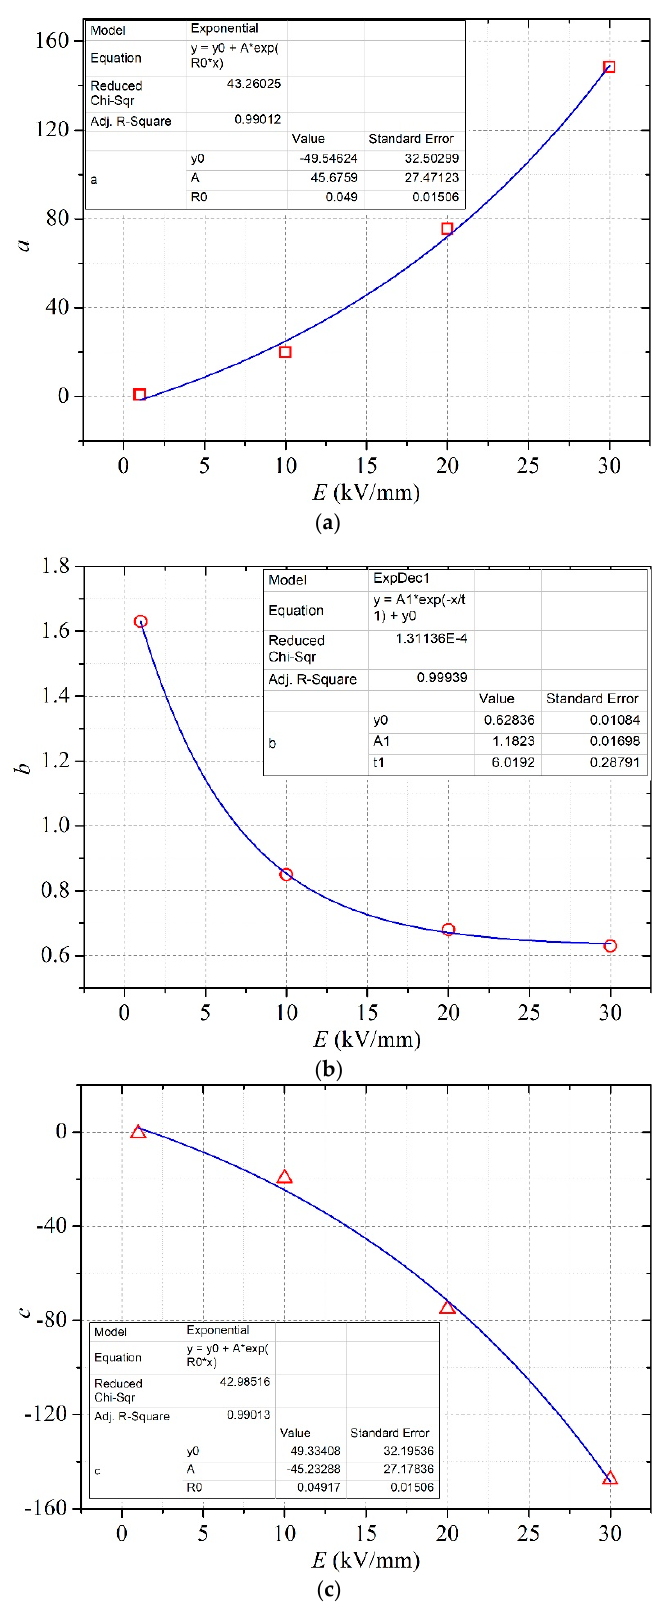
Figure 9. Relationship between the electric field strength and the values of the parameters in Equation